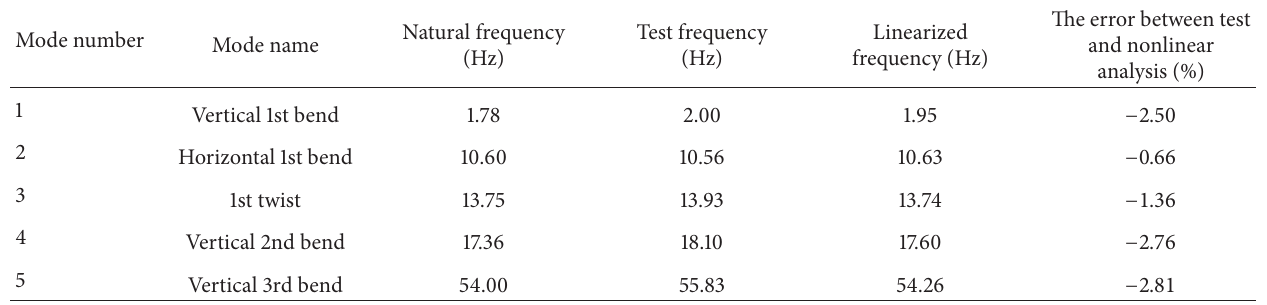
Table 1: Structure mode